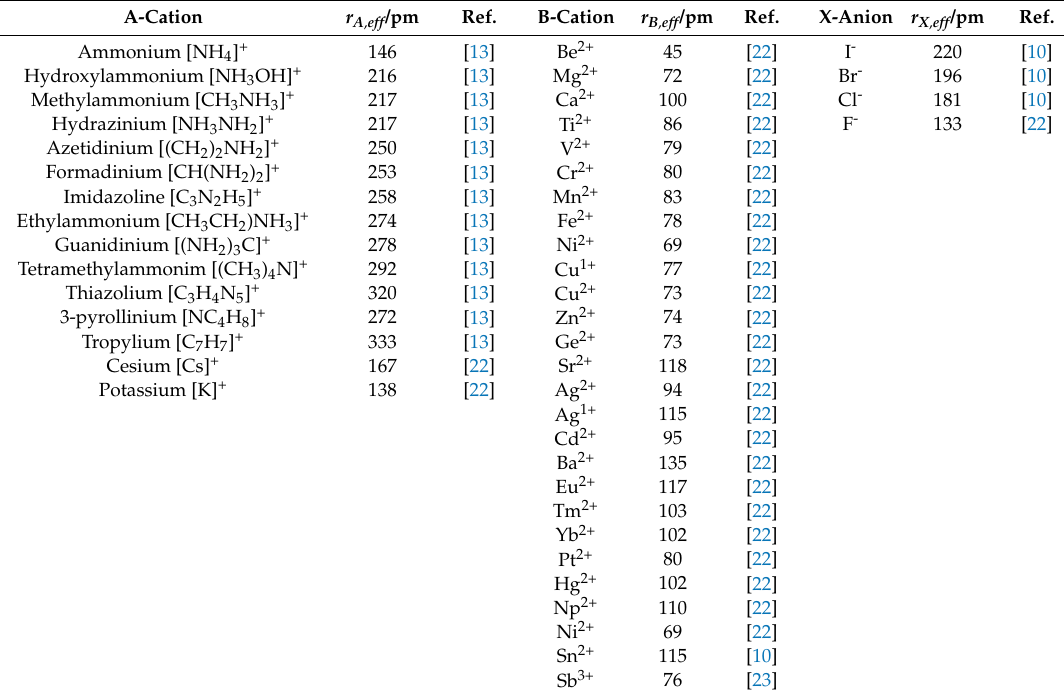
Table 1. Calculated effective ionic radii of A-organic cations, metal cations and halide anions [10,13,22,23]. A-Cation r A , eff /pm Ref. B-Cation r B , eff /pm Ref. X-Anion r X , eff /pm